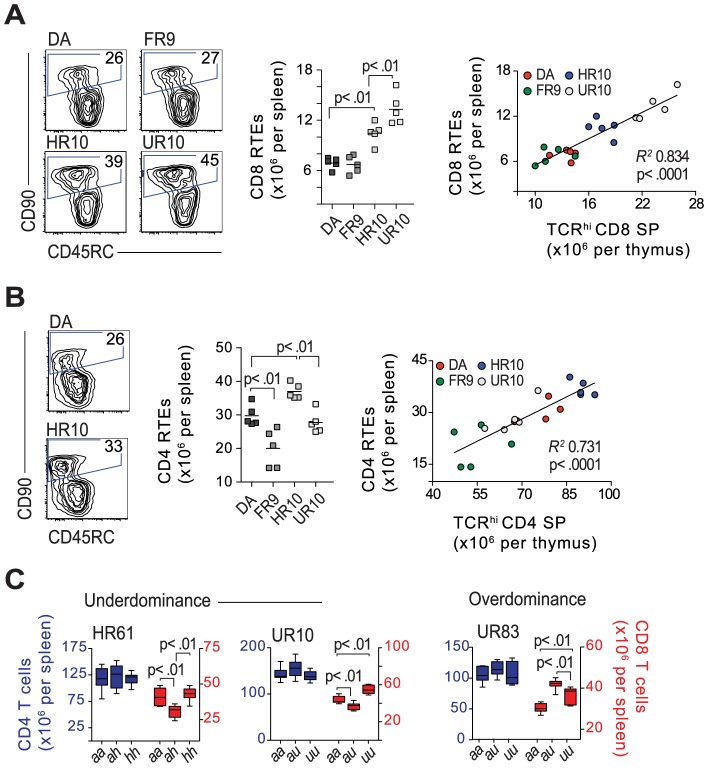
Classical cim influences the number of CD8 recent thymic emigrants.(A) Recent thymic emigrants (RTEs) express CD90 and low levels of CD45RC. Counterplots show CD8 RTEs (gated) in the spleen of 6.5-week old congenic and DA rats (representative samples, numbers in gates show percent of CD8 T cells). Scatterplot shows total number of CD8 RTEs per spleen, which correlates to the absolute number of CD8SP TCRhi cells in the thymi from the same animals (far right). (B) The corresponding staining (as shown in A) for CD4 RTEs, including total numbers (scatterplot) and correlation to CD4SP TCRhi cells in the thymus. (C) Absolute numbers of CD4 (blue) and CD8 (red) T cells in the spleen of 13-week old rats. Strains and genotypes are shown above and below graphs, respectively; n = 5–7 per group.